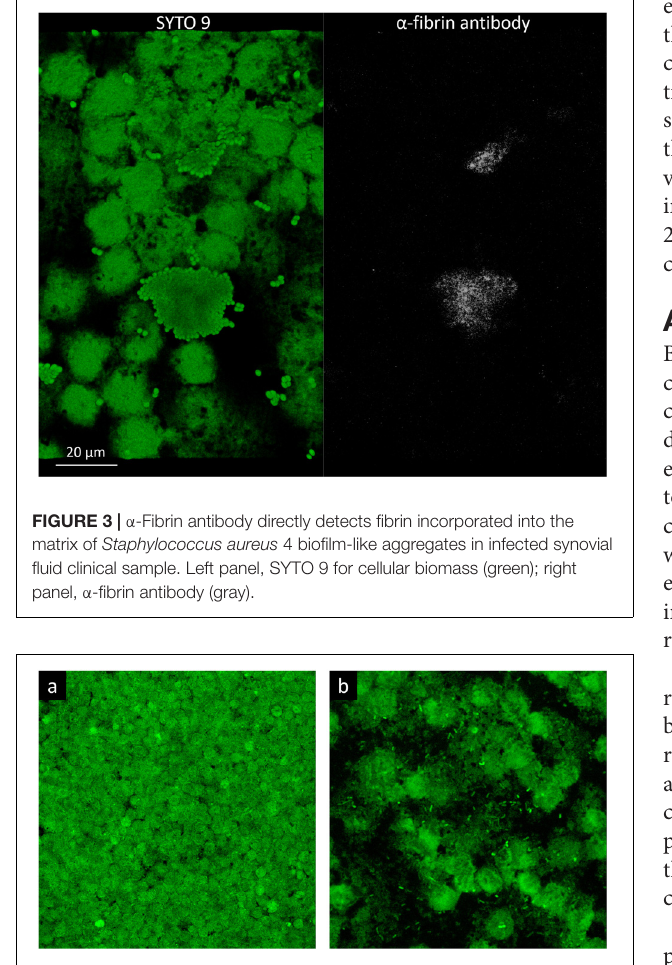
FIGURE 4 | Confocal laser scanning microscopy analysis of synovial fluid infected by Prevotella bivia stained with SYTO 9. (a) Undiluted SF and (b) SF diluted